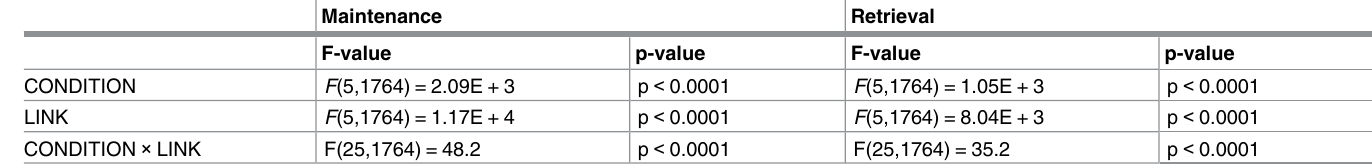
Table 3. Results from the factorial ANOVA comparing Condition and Regional Link